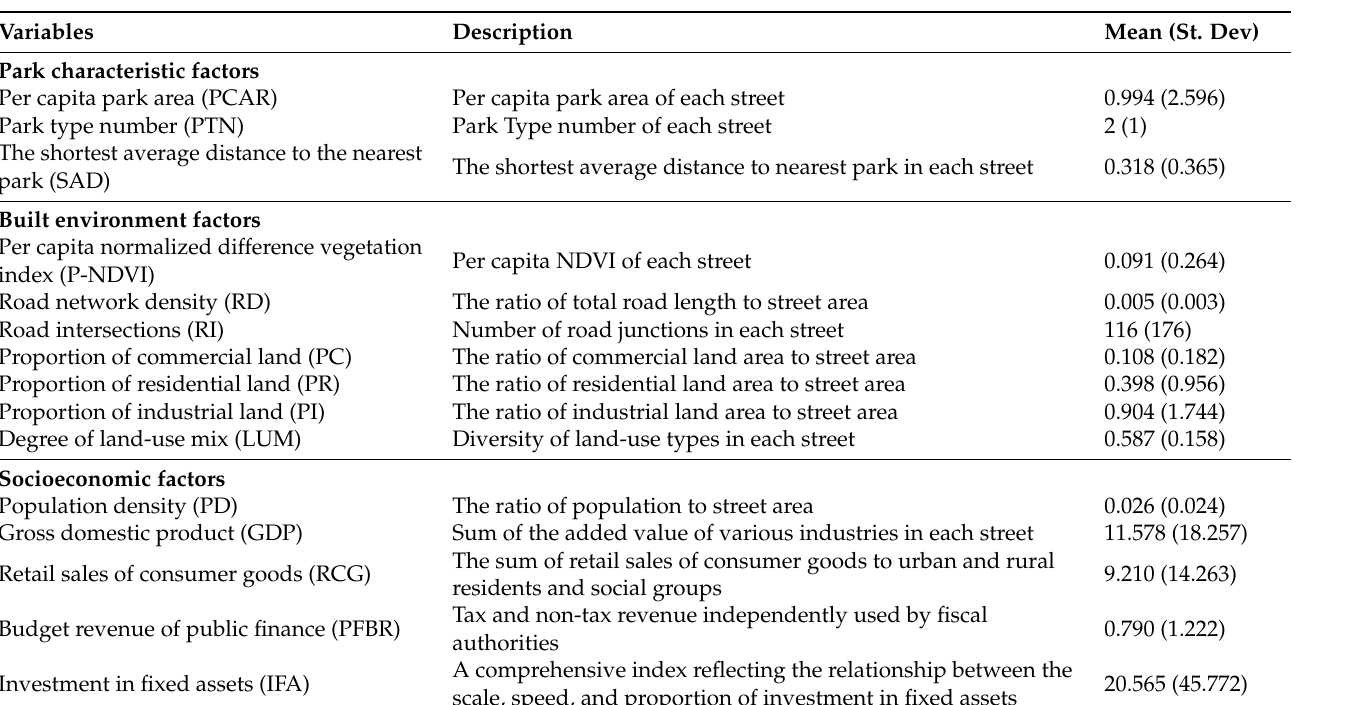
Table 1. Descriptive statistics of all